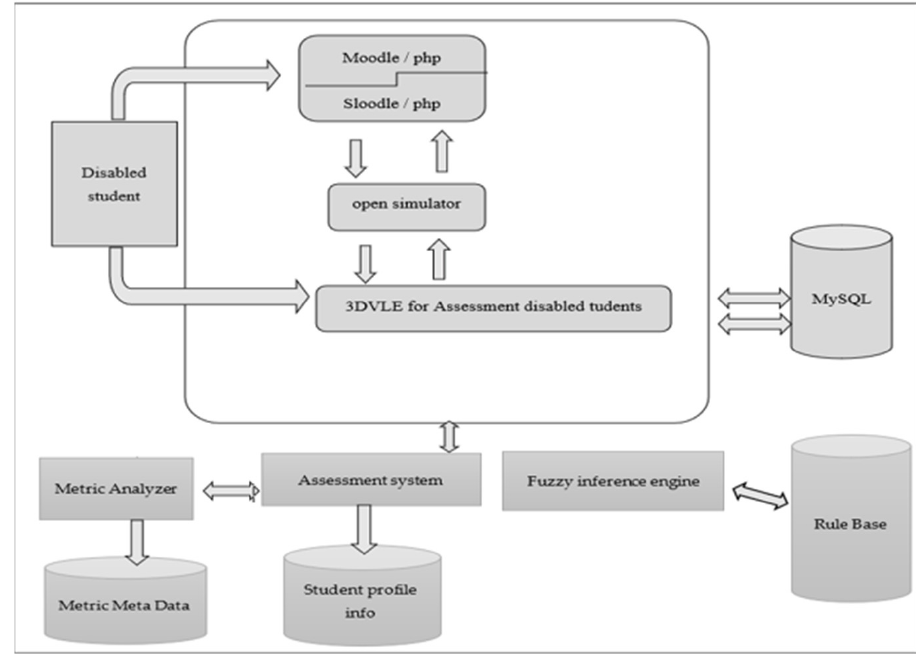
Figure 2. Proposed model for assessment of disabled students’ performance in 3D VLE.